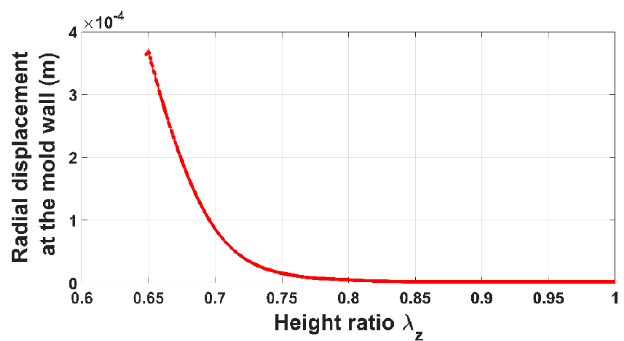
Figure 7. Radial displacement at the mold wall vs. height ratio.